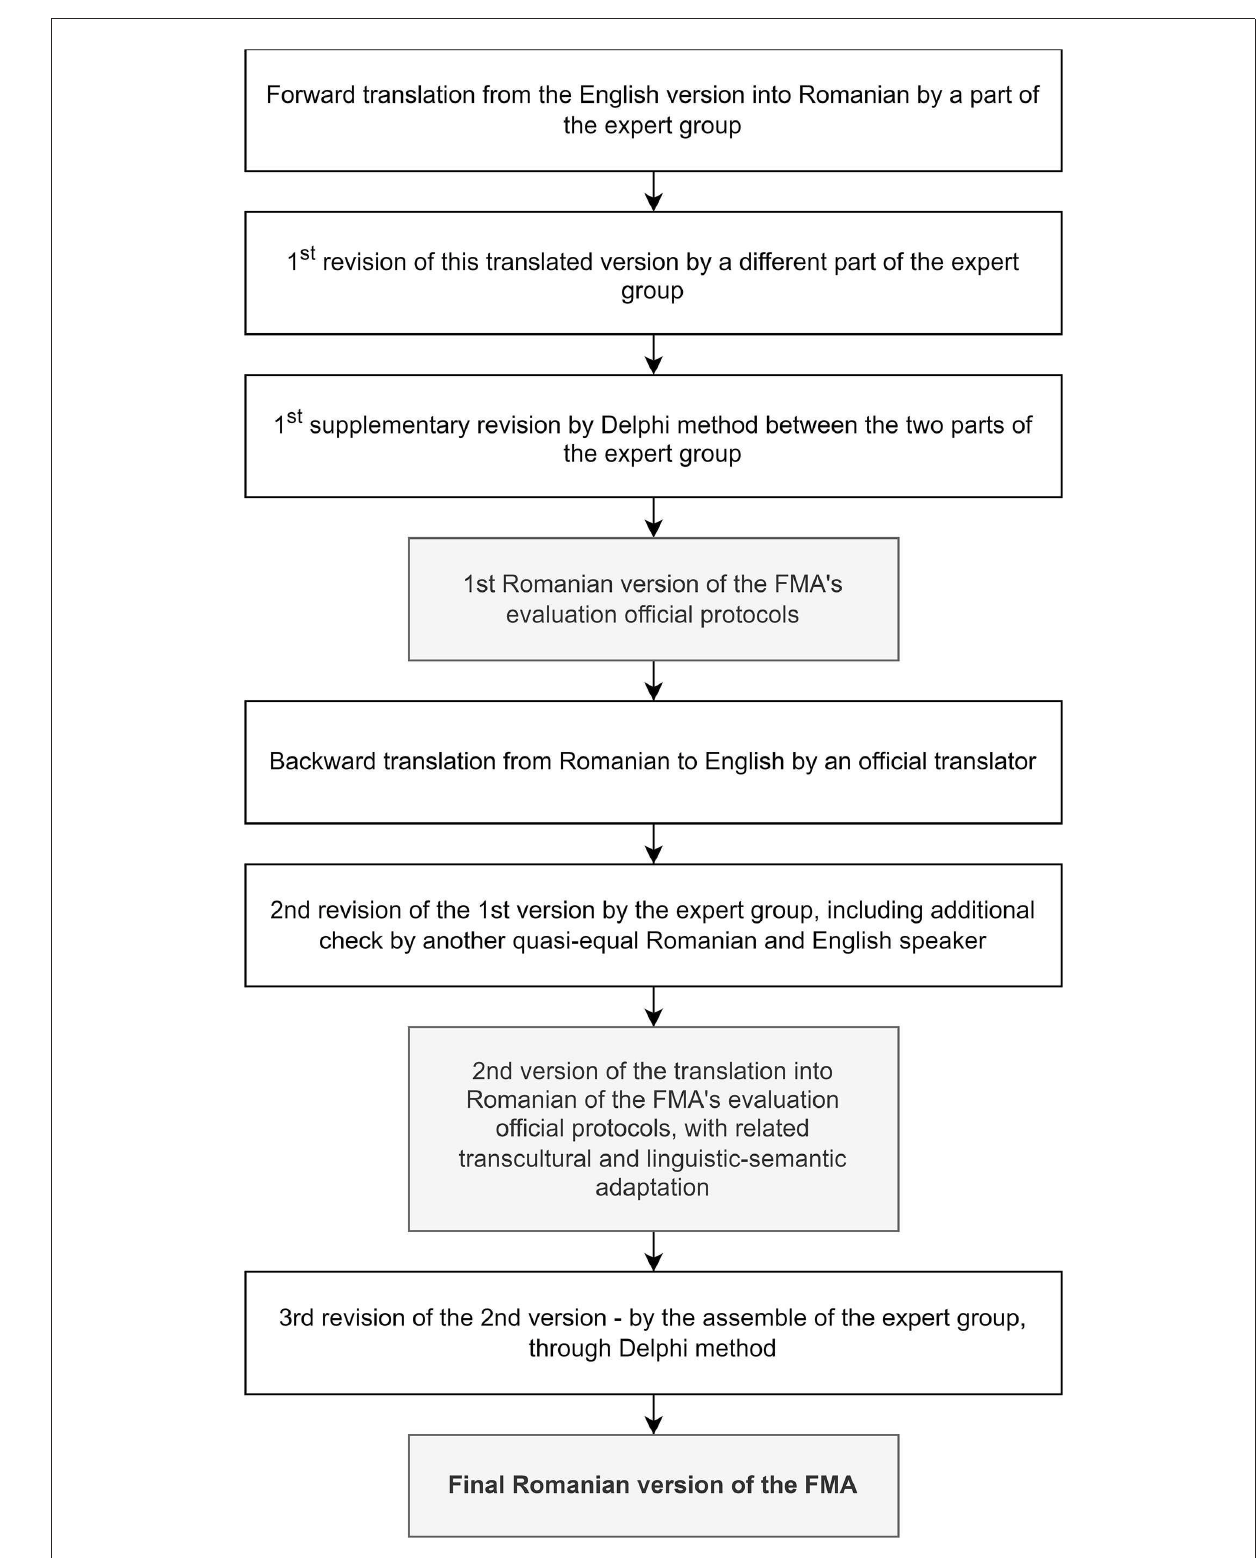
FIGURE1 The flowchart of our endeavor: a step-by-step translation of FMA’s official evaluation protocols into Romanian, with relevant transcultural and semantic-linguistic